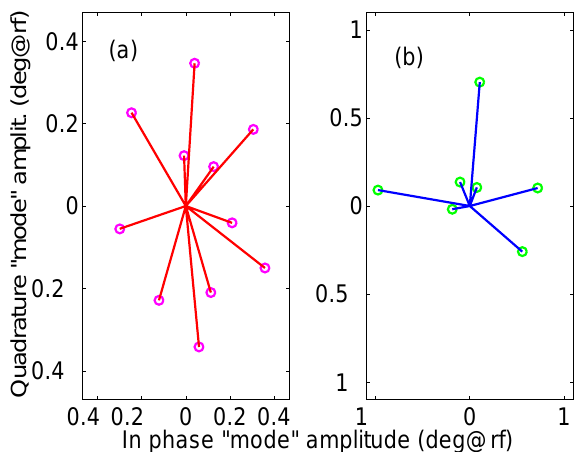
FIG. 10. (Video) A single frame from Video 2 depicts the in- stantaneous modal phase space coordinates of two sets of lon- gitudinally unstable modes in the unevenly filled PEP-II LER (same data as Fig. 9). (a) Phasors representing modes 805– 815: These modes are merely projections of a single eigen- mode. (b) Modes 780–786: These are superpositions of two or more